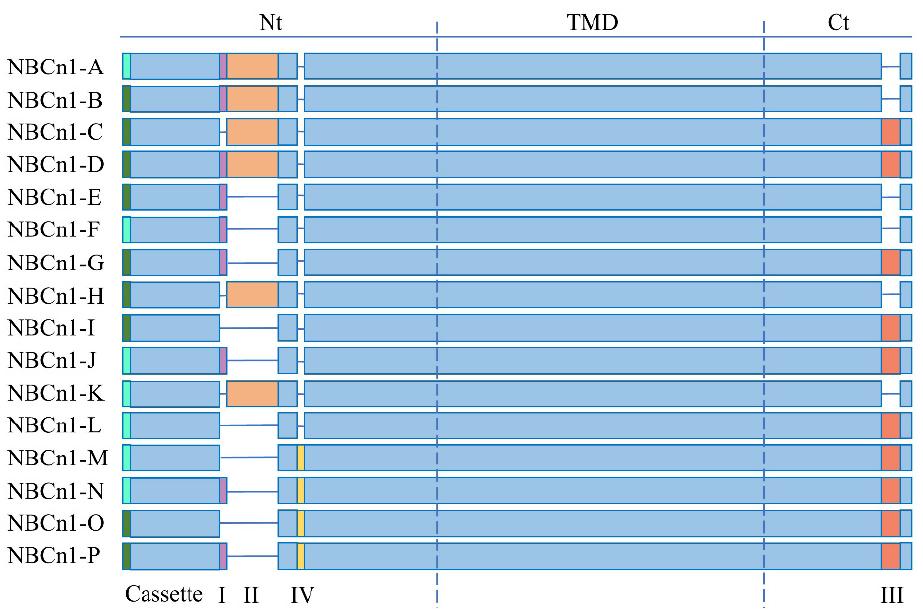
Figure 3. NBCn1 protein variants. The protein sequences contain two different Nt and can be organized into different cassettes by combining variable parts.